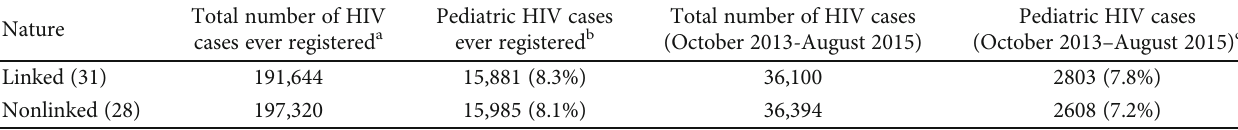
Table 1: Description of the sample size of 31 regular linked and 28 nonlinked ART